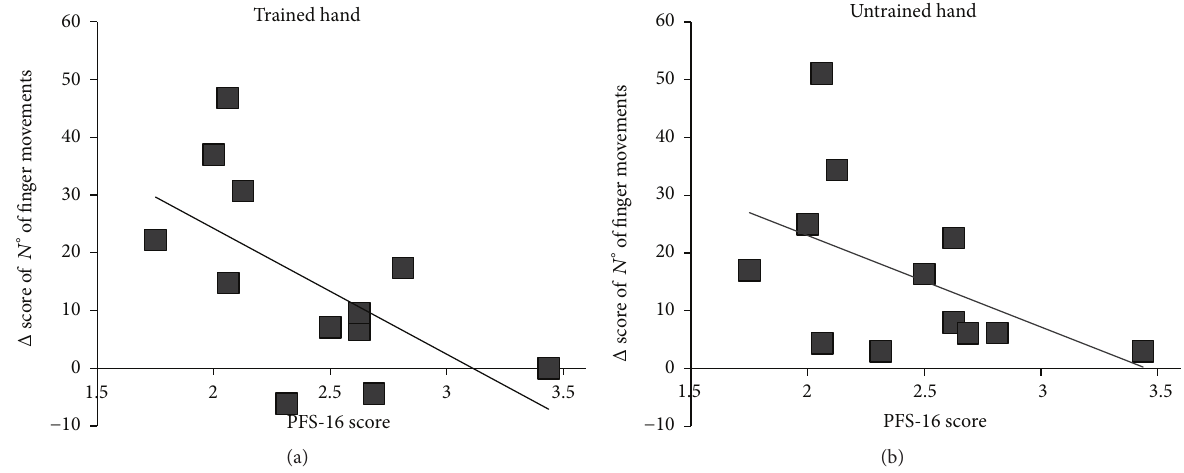
Figure 4: Correlation analysis between individual changes in the number of finger tapping movements induced by mirror visual feedback practice and individual scores at the Parkinson’s Fatigue Scale-16 (PFS-16) questionnaire in Parkinson’s disease patients. There is a significant positive correlation between the improvement in the less affected/trained hand (a) and the clinical score ( 𝑟 = 0.64 ; 𝑝 = 0.024 ), indicating that the higher the fatigability, the lower the performance improvement. In (b) the nonsignificant correlation between the improvement of the more affected/untrained hand and PFS-16 is depicted ( 𝑟 = 0.54 , 𝑝 = 0.07